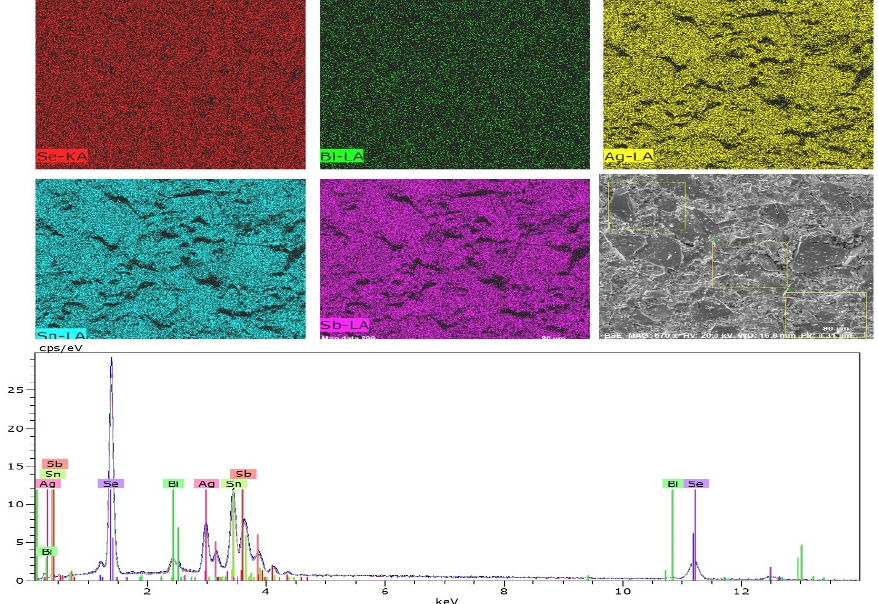
Figure 1. SEM analysis: representative EDS mapping images (powder sample) and backscattered electron image of AgSn[Bi 0.8 Sb 0.2 ]Se 3 (20 kV, 670 × ).